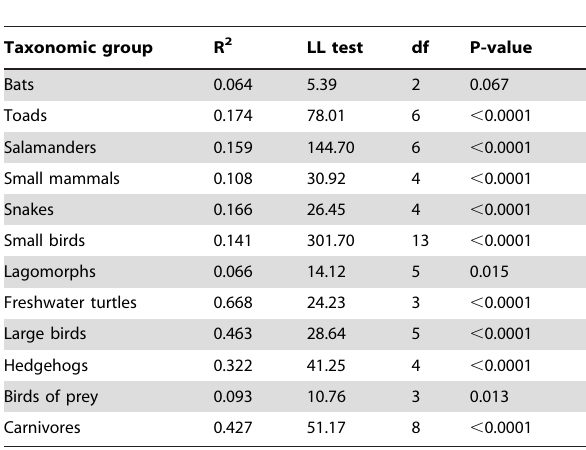
Table 3. Summary of performance parameters of Cox proportional hazards models for the 12 taxonomic groups analyzed (R 2 : explained variance, LL test: Likelihood test, df: degrees of freedom, P-value: significance of Likelihood